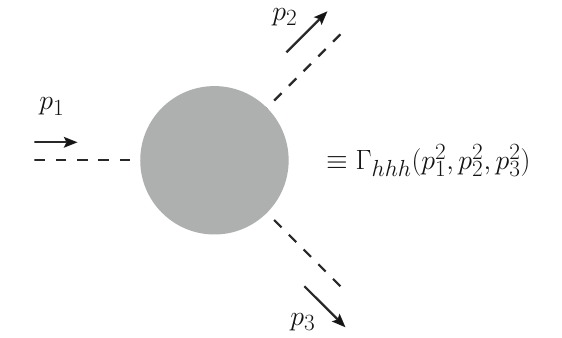
Fig. 1 Diagrammatic illustration of the Higgs three-point function (cid:13)